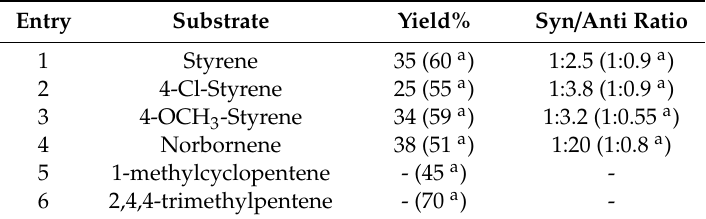
Table 1. Results for the cyclopropanation of olefins catalyzed by Ru-porphyrin functionalized DNDs. The yields were calculated from the